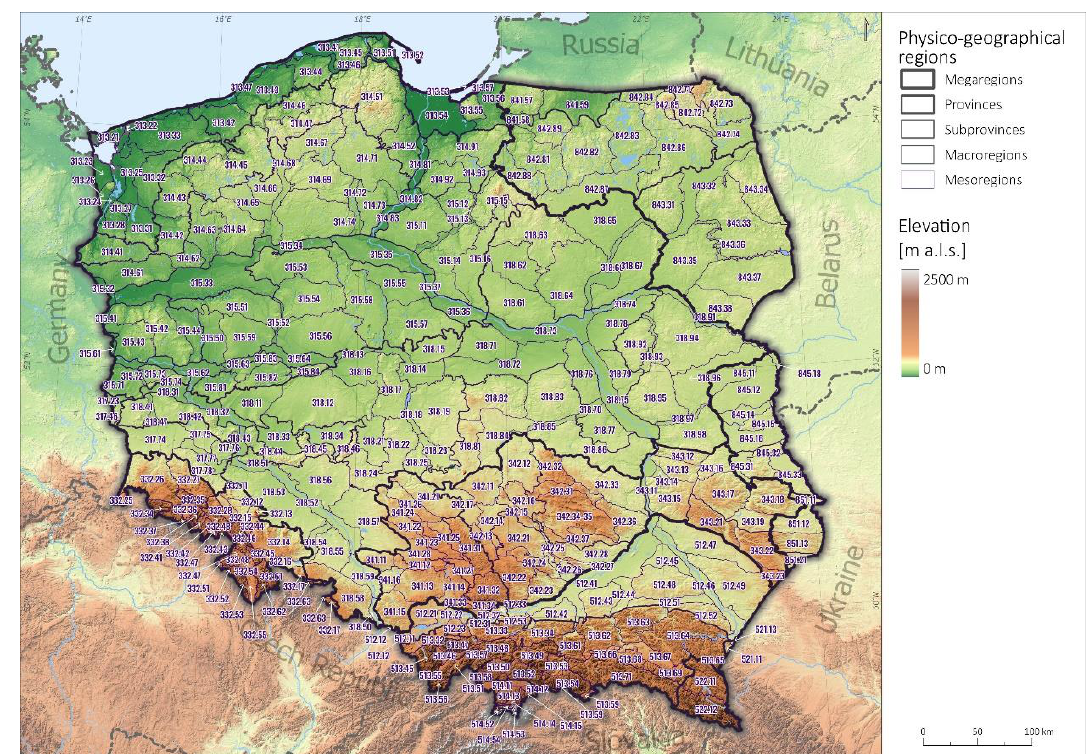
Figure 1. Polish physico-geographical regions (Source: Authors based on [26]).